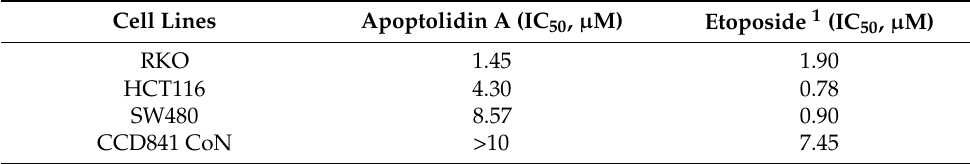
Figure 1. Effects of apoptolidin A on proliferation and colony formation in CRC cells. ( A ) The chemical structure of apoptolidin A. ( B ) Cells were seeded and treated with various concentrations of apoptolidin A for 72 h. The proliferative activity of RKO, HCT116, SW480, and CCD841 CoN (normal epithelial colon cell) cells were evaluated using the sulforhodamine B (SRB) assay. ( C ) The effect of apoptolidin A on colony formation. Cells were treated with apoptolidin A for 72 h, followed by additional incubation for 2 weeks. Data are presented as the mean values ± SD from three-independent experiments. * p < 0.05, *** p < 0.001 indicates statistically significant difference compared to the vehicle-treated control. Table 1. Antiproliferative activities of apoptolidin A in colorectal cancer cells.